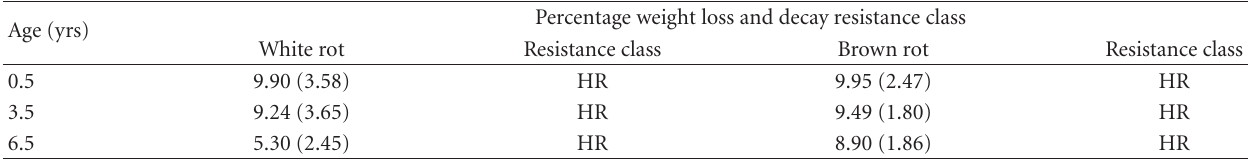
Table 4: Percentage weight loss and decay resistance class for white and brown rot fungi.